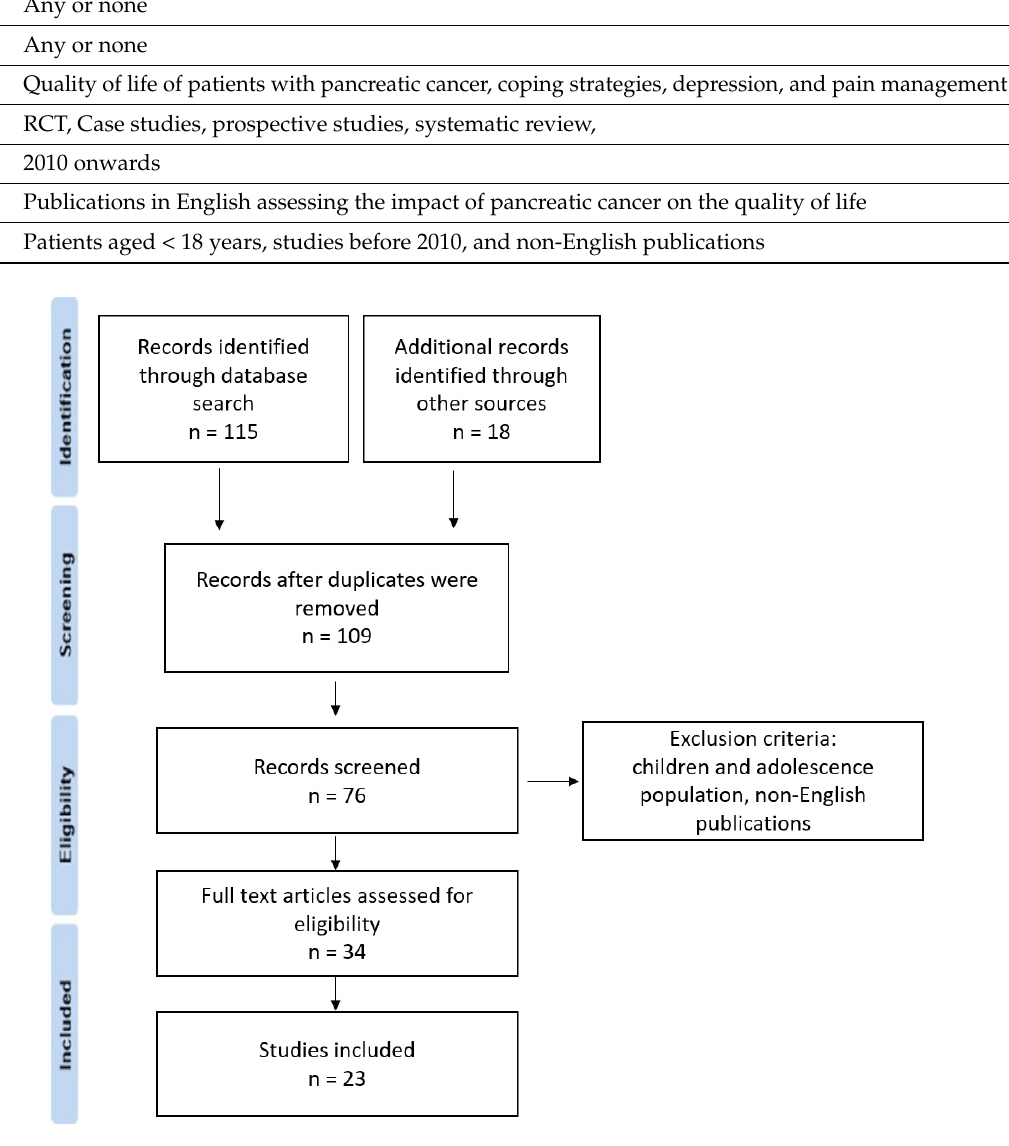
Figure 1. Simplified PRISMA scheme.